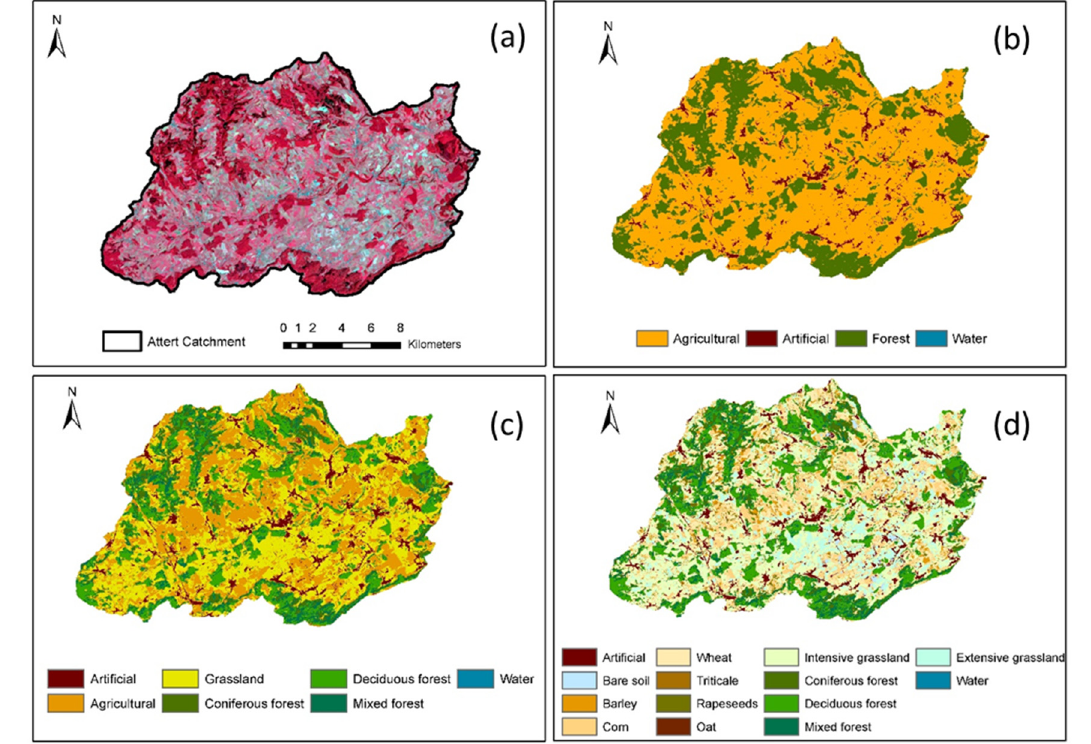
Figure 4. Four land cover maps from Landsat 8 of July 2013: ( a ) False color composite image in RGB combination of bands 5, 4, 3; ( b ) Level 1 classification image with 4 classes by k-NN based on the 10 bands combination of the Landsat image; ( c , d ) Level 2 and Level 3 classification images with 7 and 14 classes by Random Forest based on the 10 bands